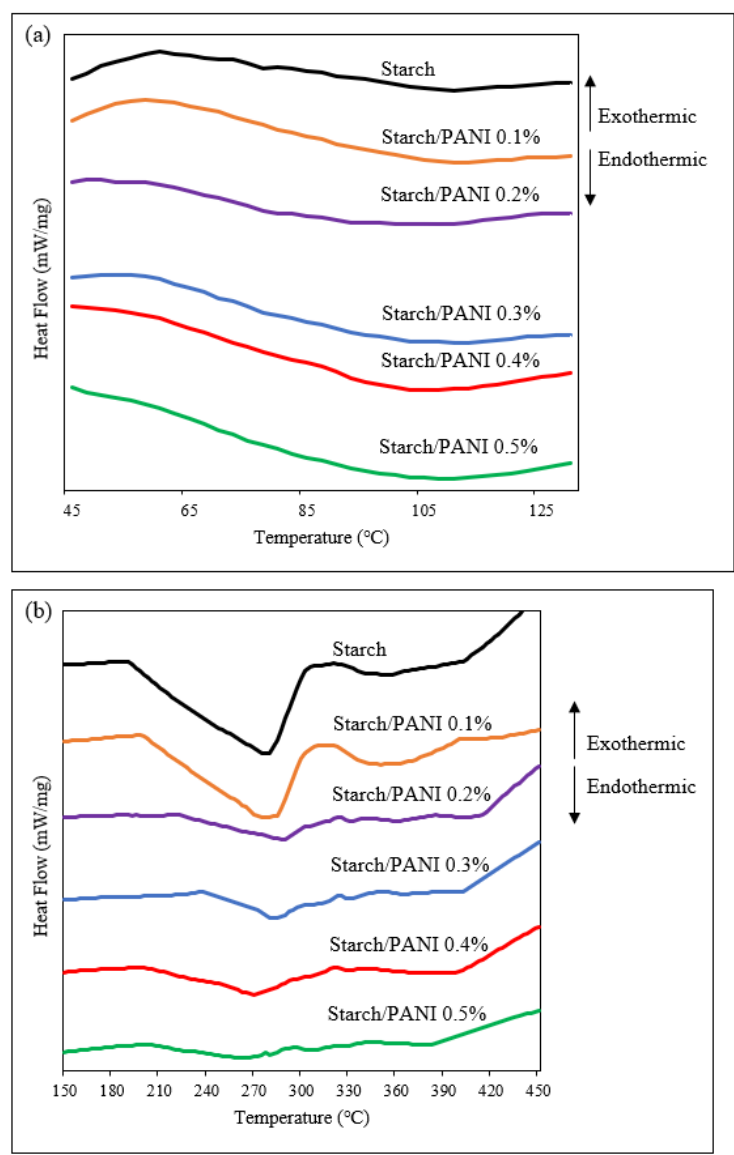
Figure 7. DSC thermograms of starch and starch/PANI (0.1%, 0.2%, 0.3%, 0.4%, 0.5%)-polymer films from ( a ) 45 °C to 130 °C and ( b ) 150 °C to 450 °C.